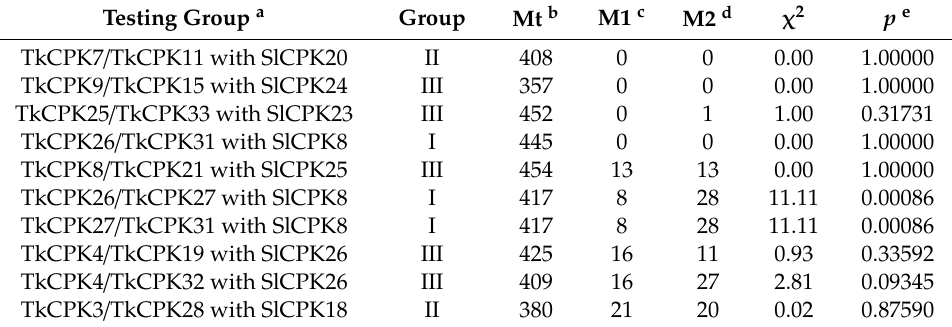
Table 2. Tajima relative rate tests of CPK gene pairs in Taraxacum koksaghyza